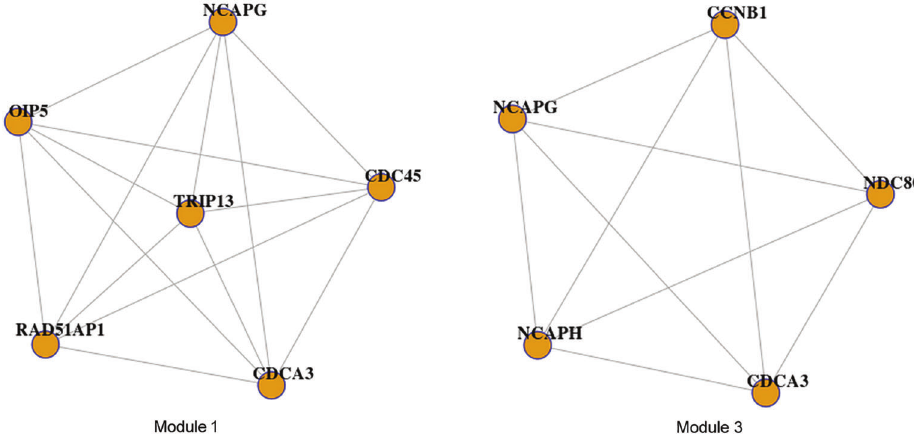
Figure 4. Attractor modules identi fi ed according to the method of integrating clique-merging algorithm and attract.